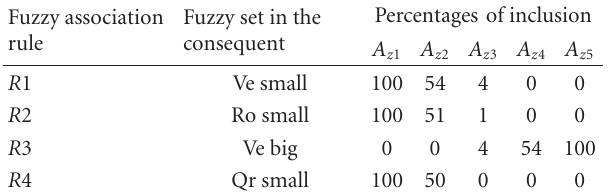
Table 6: Percentages of the confidence index for the fuzzy association